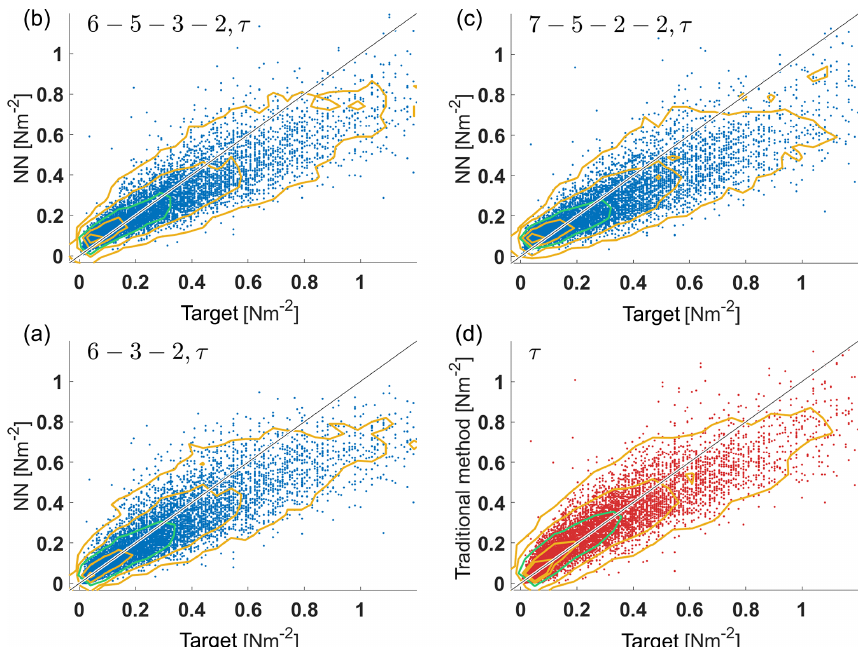
Figure 5. Plots of network output vs. target values for momentum flux on unknown test data (DE-Keh). The 6–3–2 ANN ( a ), 6–5–3–2 ANN ( b ), 7–5–2–2 ANN ( c ) and the MOST method ( d ) are shown. Contours represent the kernel density estimates of the two-dimensional probability density distribution with the 95th, 75th, 25th and 5th percentiles (yellow contours – starting from the outermost contour) and the 50th percentile (green contour).